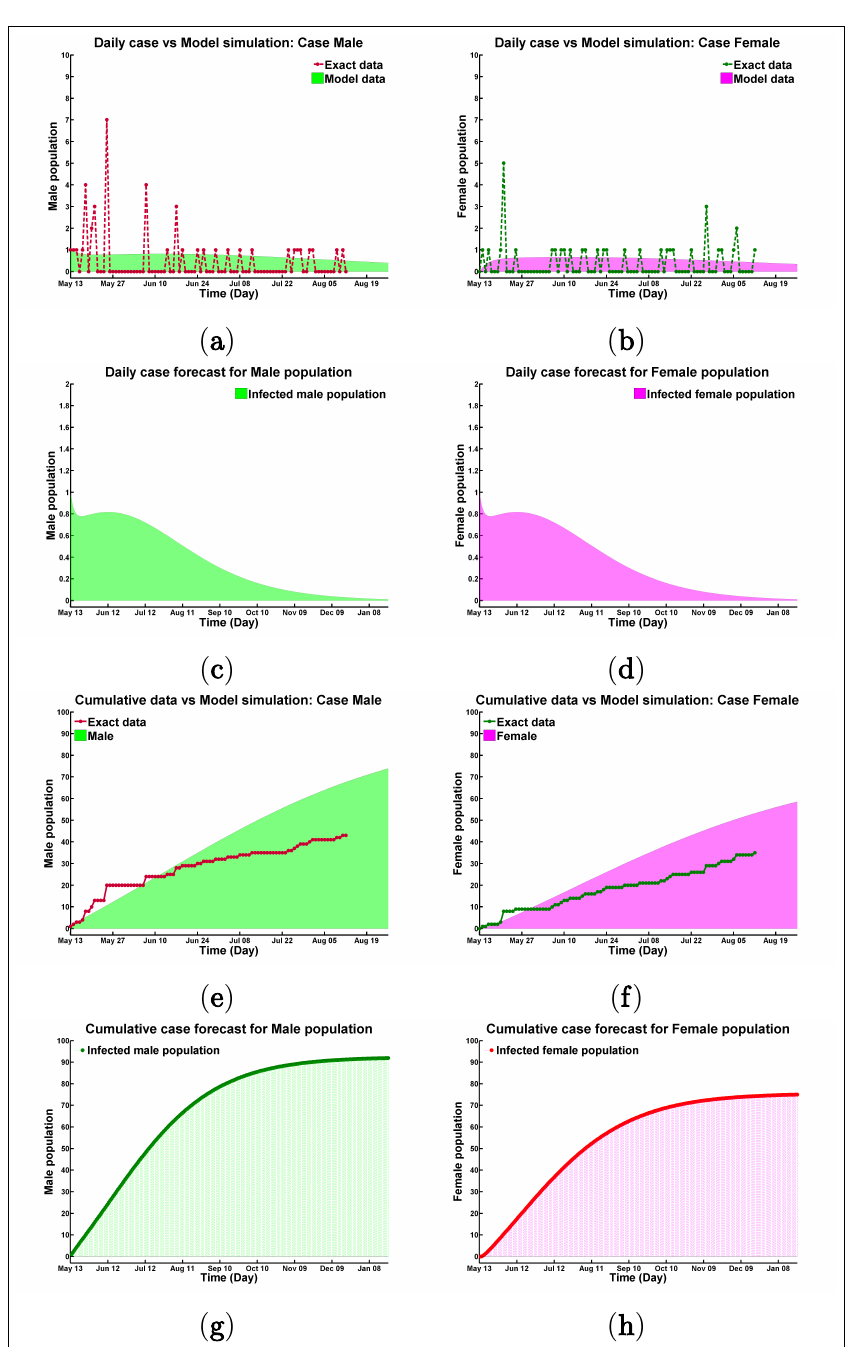
Figure 3: Visual presentation of Gender disparity (Male cases versus Female cases) for Figure 3. Visual presentation of gender disparity (Male cases versus Female cases) for model best fitting with real model best fitting with real data.